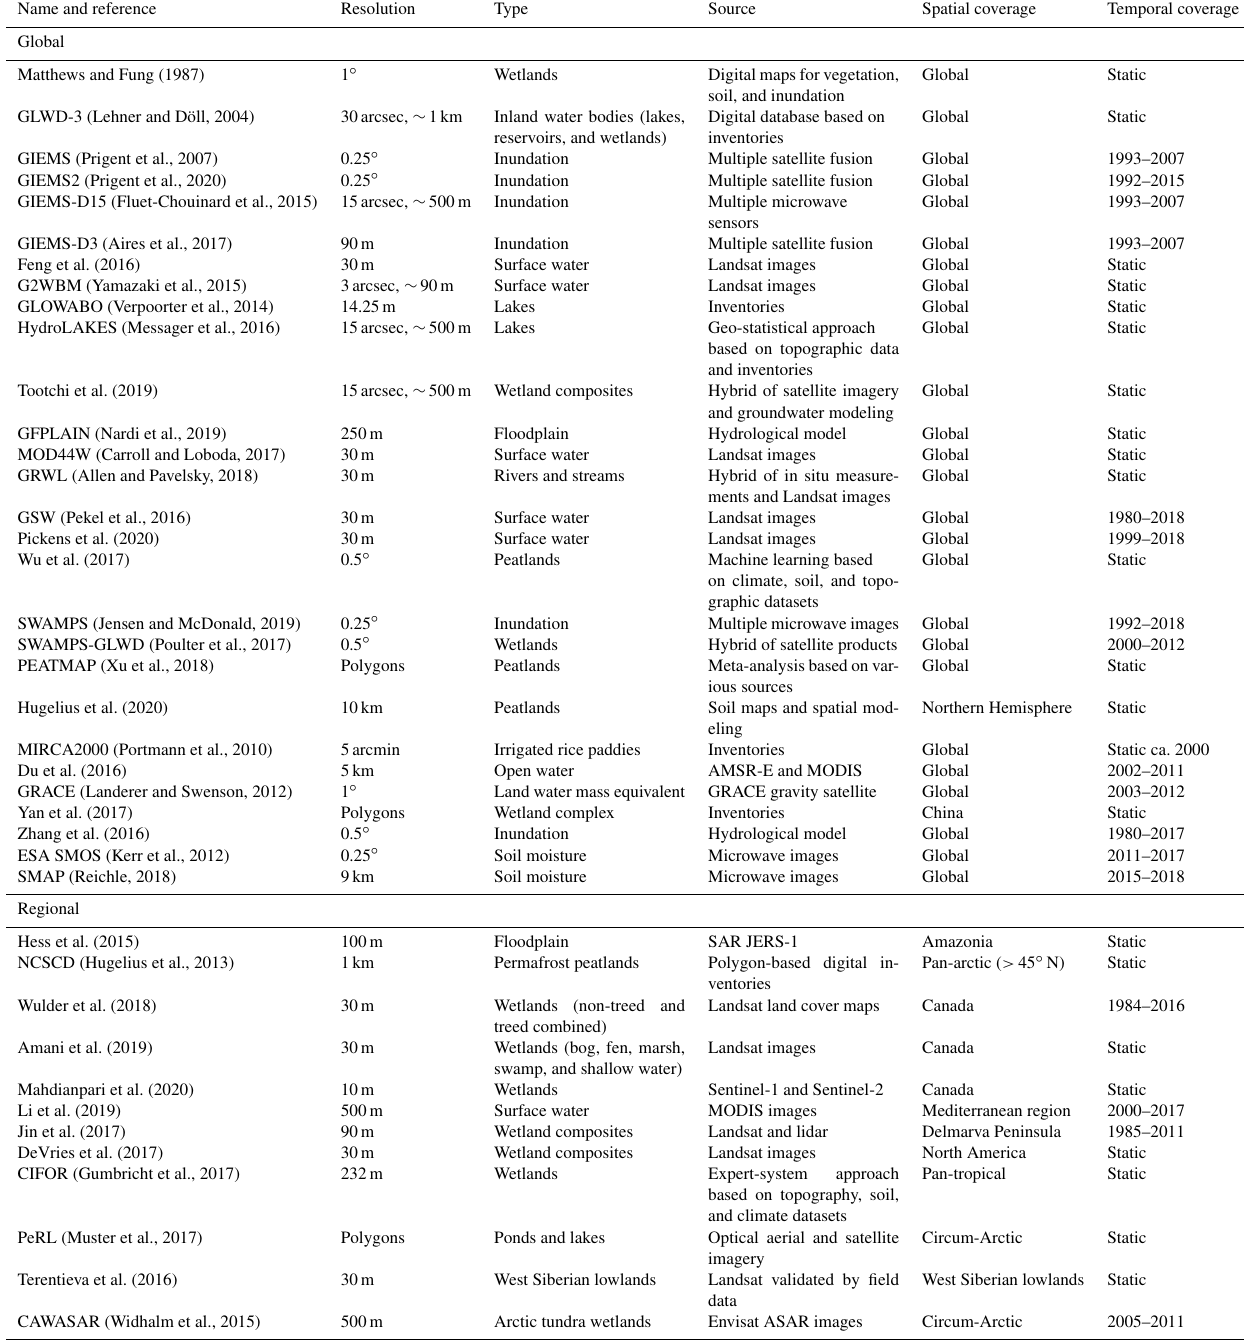
Table A1. Overview of existing global and regional datasets of open water and wetlands and related proxy